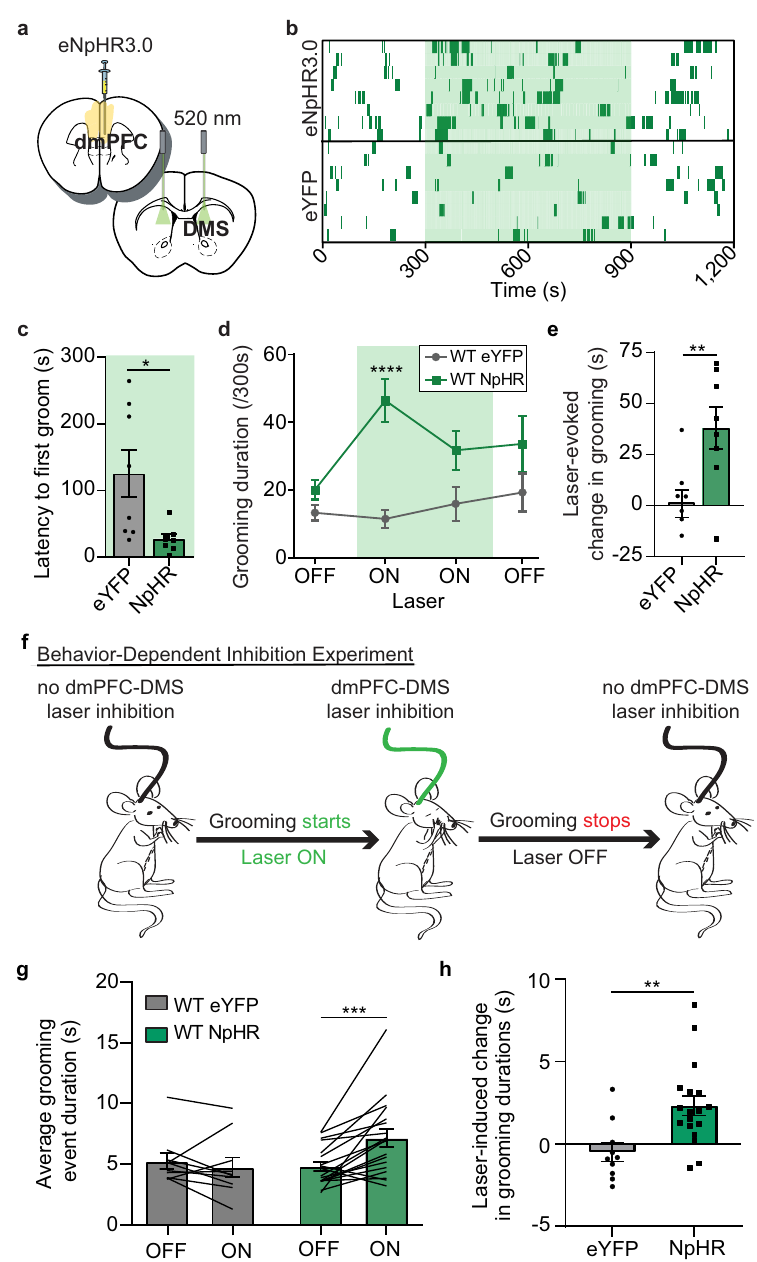
Fig. 5 Optogenetic inhibition of dmPFC-DMS projections increases grooming in WT mice. a WT mice are bilaterally injected with CaMKII α -eNpHR3.0 virus in the dmPFC and implanted bilaterally with optical fi bers in the DMS. b Raster-like plot of grooming behavior for individual animals across experimental timeline (top: eNpHR3.0; bottom: eYFP control). Each row represents one animal. Dark green dashes indicate grooming timestamps and light green shading indicates when laser was on (8 mice per group). c eNpHR3.0 mice began grooming signi fi cantly sooner than eYFP mice after laser onset (unpaired two-tailed t -test P = 0.0150). d eNpHR3.0 mice ( N = 8) show increased grooming during laser on epochs that is signi fi cantly higher than eYFP controls ( N = 8) (two-way RM ANOVA: interaction P = 0.0395, laser P = 0.0841, virus group P = 0.0010, subject P = 0.1264; Sidak ’ s multiple comparisons: eNpHR3.0 vs eYFP fi rst laser on epoch P < 0.0001). e Bar graph quantifying data from ( d ) showing that eNpHR3.0 mice have a signi fi cant laser-evoked increase in grooming compared to eYFP mice (unpaired two-tailed t test P = 0.0083). f graphical representation of behavior-dependent inhibition experiment. g Mice expressing eNpHR3.0 ( N = 18) show an average increase in the duration of grooming epochs when the laser is turned on during grooming that is not seen in eYFP-WT mice ( N = 10) (two-way RM ANOVA: interaction P = 0.0043, laser P = 0.0526, virus P > 0.5, subject P = 0.0010; Sidak ’ s multiple comparisons: eNpHR3.0 Off vs eNpHR3.0 On P = 0.0004). Black lines represent individual animals. Lines start and stop at individual animal ’ s average grooming event duration during laser off and on conditions. h Laser inhibition of dmPFC-DMS projections signi fi cantly extends the average duration of grooming epochs in NpHR-WT mice ( N = 18) compared to eYFP-WT mice ( N = 10) (unpaired two-tailed t -test P = 0.0043). Bar and line graphs show data means + / − SEM. Source data are provided as a Source data fi le. * P < 0.05, ** P < 0.01, *** P < 0.001, **** P <